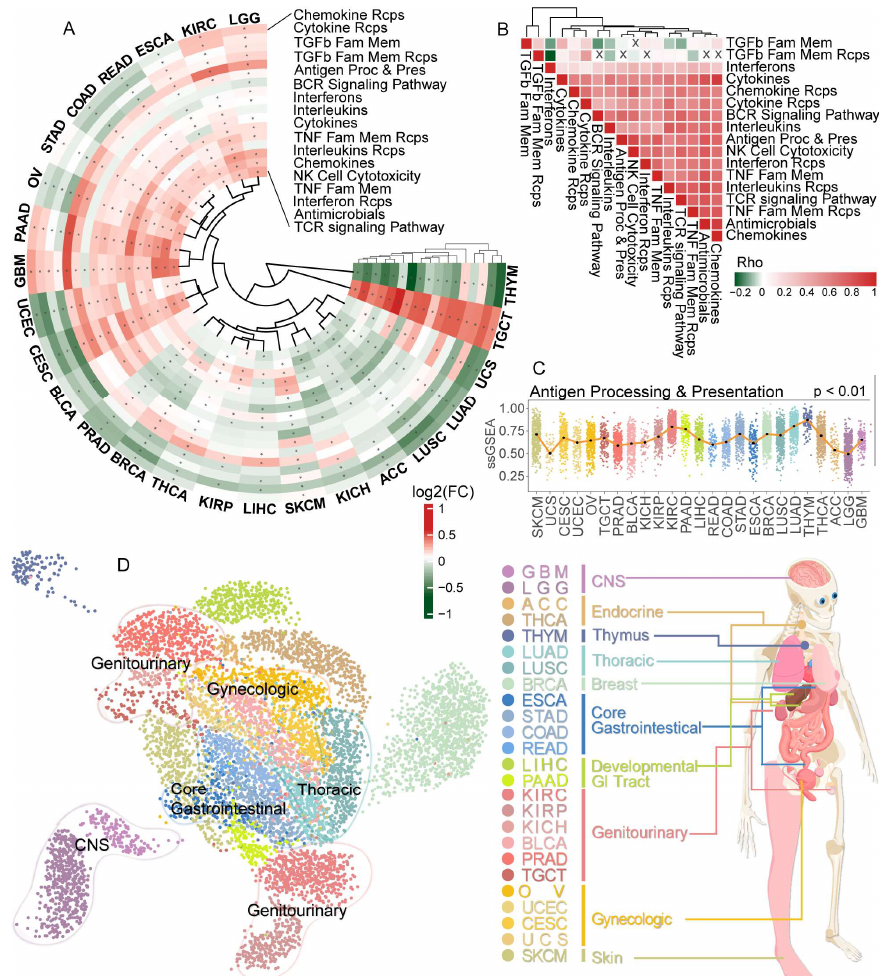
Figure 1. Dysregulated immune-related pathways in pan-cancer. ( A ) Circos heatmap showing the comparison of IRP expression level between tumor and normal across 25 cancer types. ‘*’ denotes a significant dysregulation. ( B ) Correlation heatmap of IRPs in pan-cancer. ‘X’ denotes no significant correlations. ( C ) Normalized IRP scores across 25 cancer types. ( D ) TCGA tumor samples clustered by Uniform Manifold Approximation and Projection (UMAP) analysis. Different colors denote various cancer types. Cancer types included: adrenocortical carcinoma (ACC), bladder urothelial